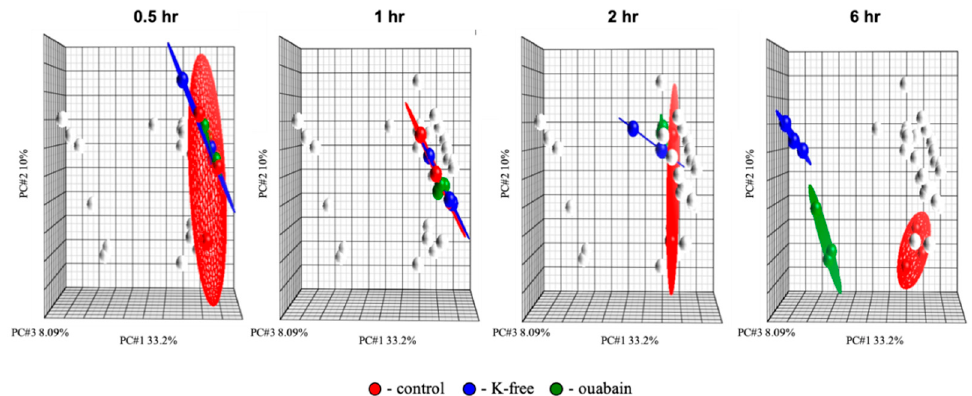
Figure 2. Principal component analysis (PCA) of the transcriptomic changes in human umbilical vein endothelial cells (HUVEC) triggered by Na,K-ATPase inhibition by 3 µ M ouabain and incubation in K + -free medium for 0.5, 1, 2, and 6 h. Ellipsoids highlight portioning of samples based on the type of treatment. The principal components in the three-dimensional graphs (PC #1, PC #2, and PC #3) represent the variability of gene expression level within the datasets. Each point on the PCA represents the gene expression profile of an individual sample. Samples that are near each other in the resulting three-dimensional plot have a similar transcriptome, while those that are further apart have dissimilar transcriptional profiles. White dots, as well as green, red and blue, represent overall statistically significant transcriptomic changes. In turn, green, red and blue dots show the di ff erentially expressed genes sets specific to each stimulus which change at di ff erent time points. All experiments were repeated three times. Table 1. Time-dependent e ff ect of Na,K-ATPase inhibition on genes expression in HUVEC. Ouabain K + -Free Medium 0.5 h Number of di ff erentially expressed genes Number of up-regulated genes Number of down-regulated